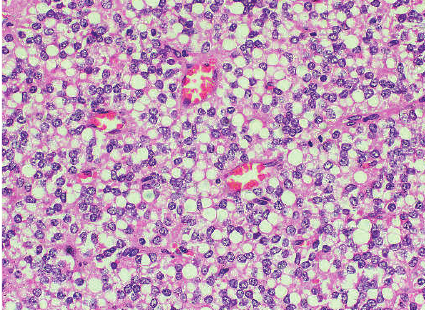
Figure4:Haematoxylinandeosinstainedsectionshowingsheetsof polygonalcellsdisplayingblandnucleiandathinrimofeosinophilic cytoplasmcontainingsharpvacuolations.Occasionalmitoticfigures are present ( ×